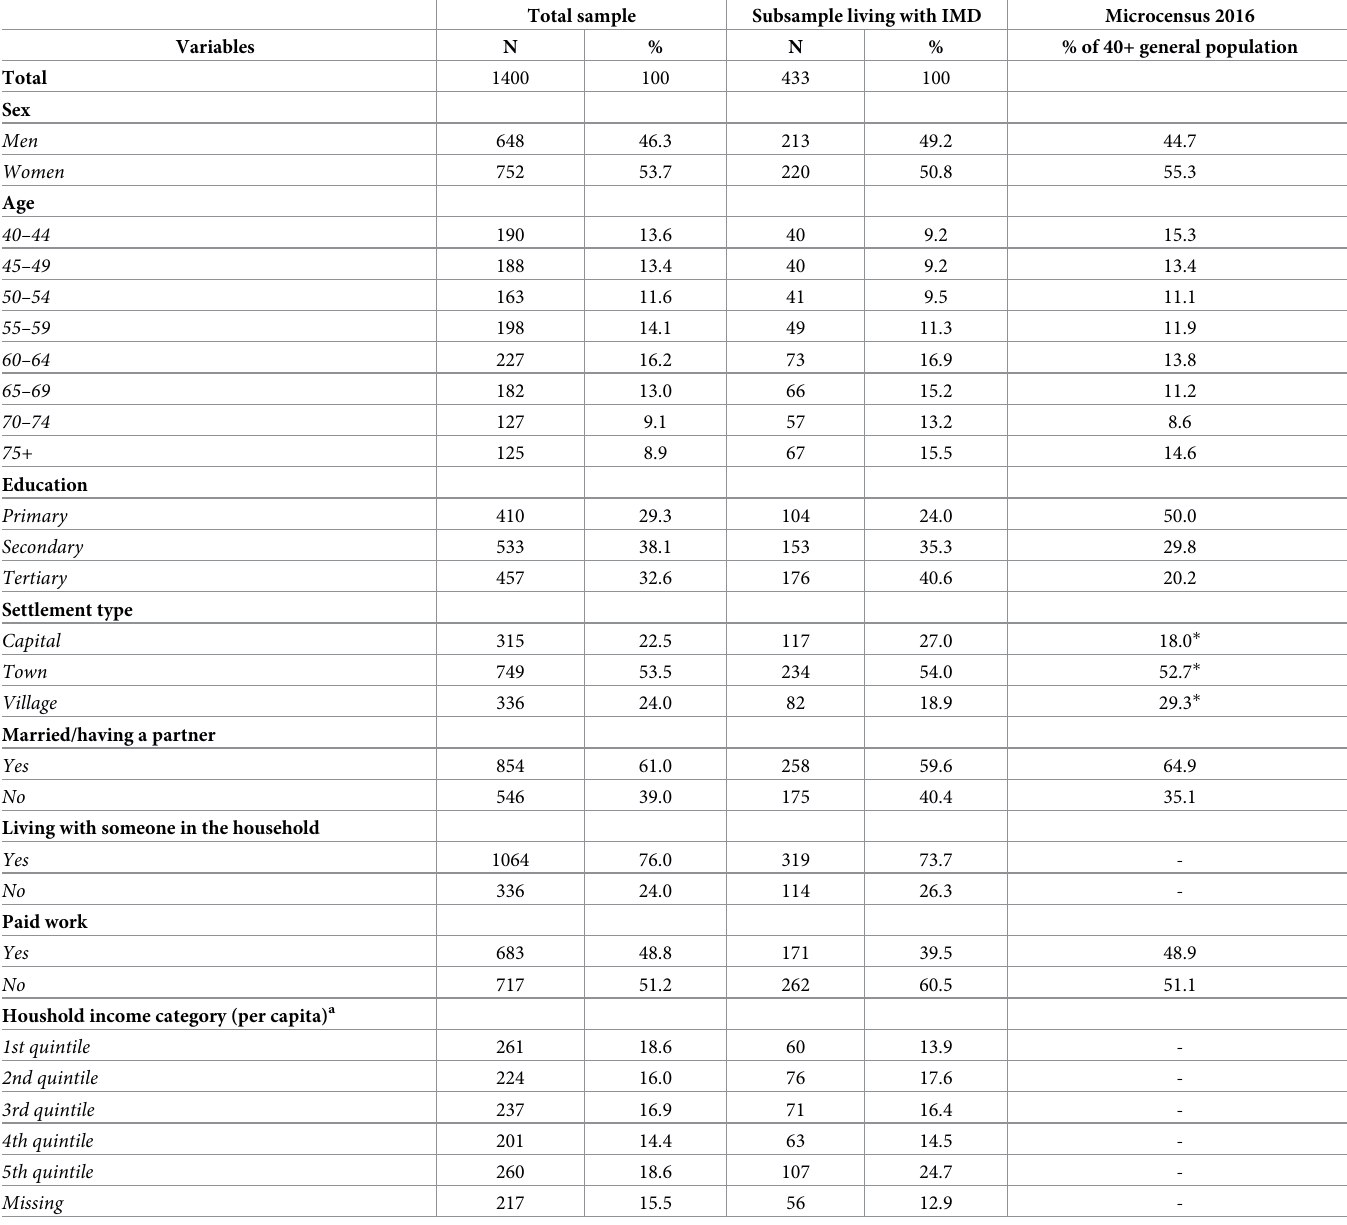
Table 1. Sociodemographic characteristics of the